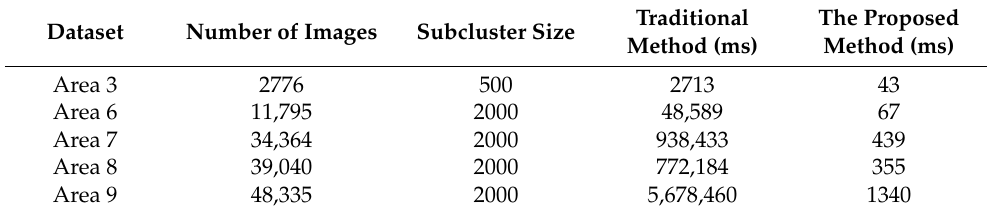
Table 3. Image expansion efficiency